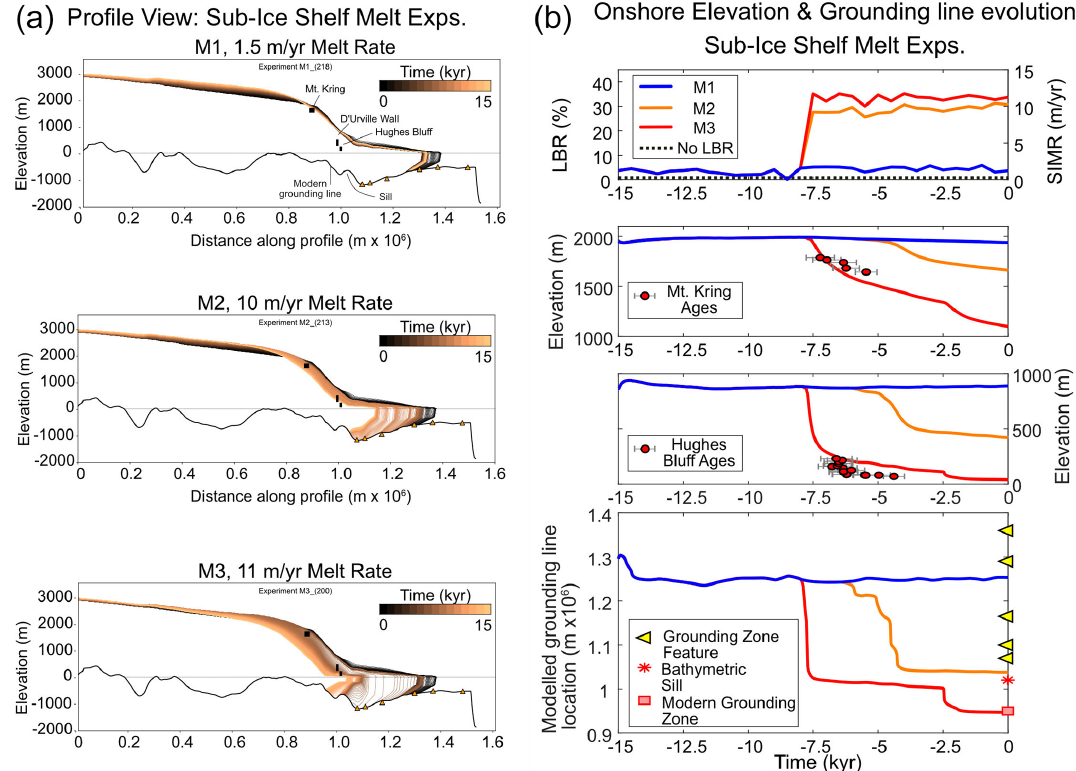
Figure 9. (a) Profile view: 15kyr evolution of modelled upper ice surface along flowline for sub-ice-shelf melt rate (SIMR) experiments. Black bars represent elevation range from three sites in this study. Orange triangles represent offshore features marking observed grounding zone wedges. (b) Onshore elevation and grounding-line evolution for SIMR experiments. Top subpanel: forcings applied (no relationship between LBR and SIMR). In SIMR cases, we varied the SIMR perturbation within a 0.5m/yr window at 500-year temporal frequency to simulate short-lived pulses of relatively warmer or cooler water mass changes. Top middle subpanel: time-transgressive elevation profile for Mt Kring with exposure ages; bottom middle subpanel: time-transgressive elevation profile for Hughes Bluff surface exposure ages; and lower subpanel: evolution of grounding-line position with modern grounding-line position, bathymetric sill at the mouth of David Fjord and mapped grounding zone features. We co-view exposure age data in these plots to allow generalised time-varying geometric relationships to be